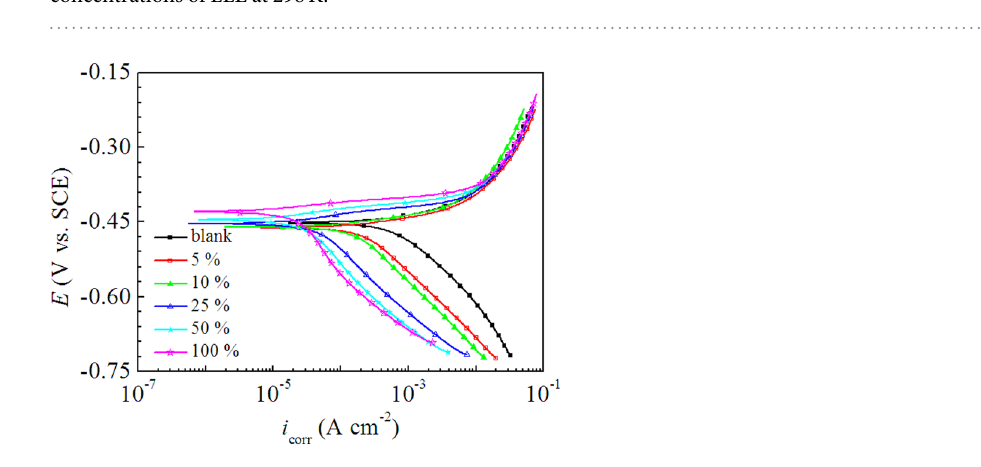
Figure 1. The OCP-time curves for mild steel in 0.5 M H 2 SO 4 solution containing different different V/V concentrations of LLE at 298 K.